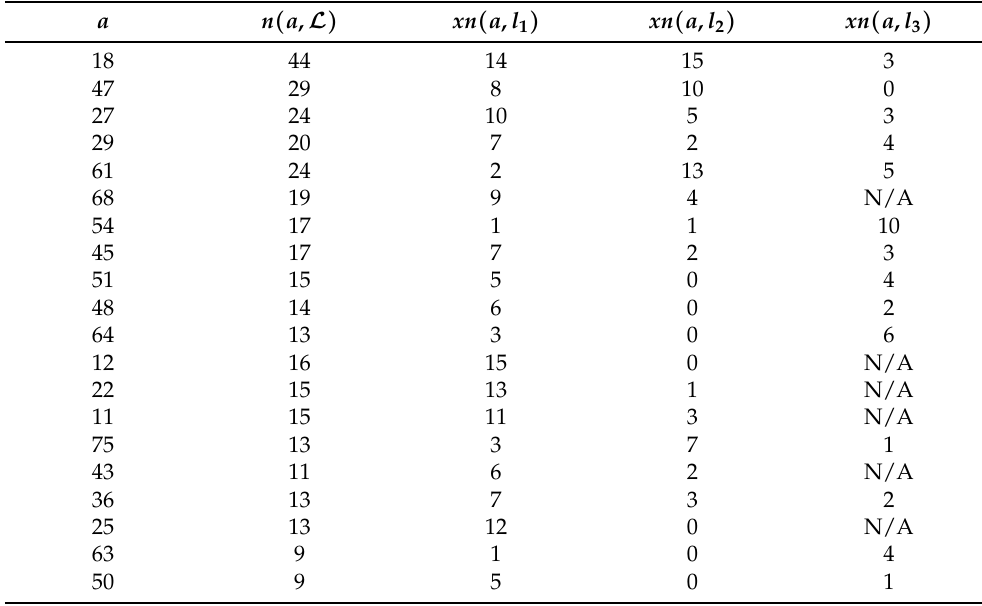
Table 3. Neighborhood computed on 20 highest-degree actors of the whole Montagna multiplex network and exclusive neighborhood computed on its single